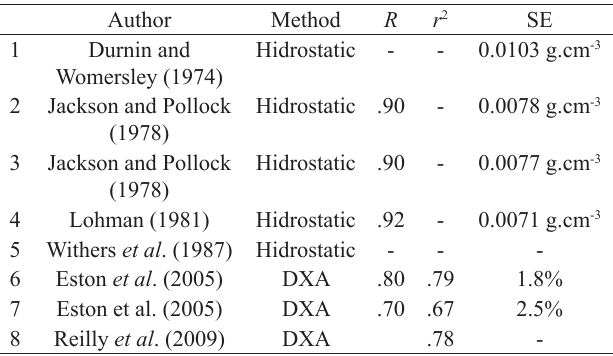
1. Equations in the literature to predict body fat (author, method, equation, correlation coefficient, coefficient of determination, standard error of estimate ) the statistics were reported in the original studies.